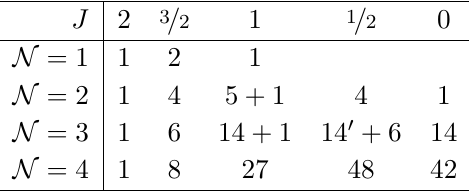
Table 1 . USp(2 N ) representations of spin J content of Weyl